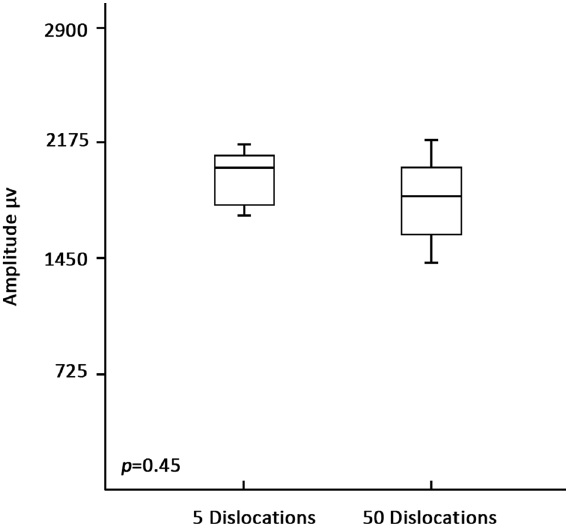
Figure 3. Amplitude profiles after multiple APS